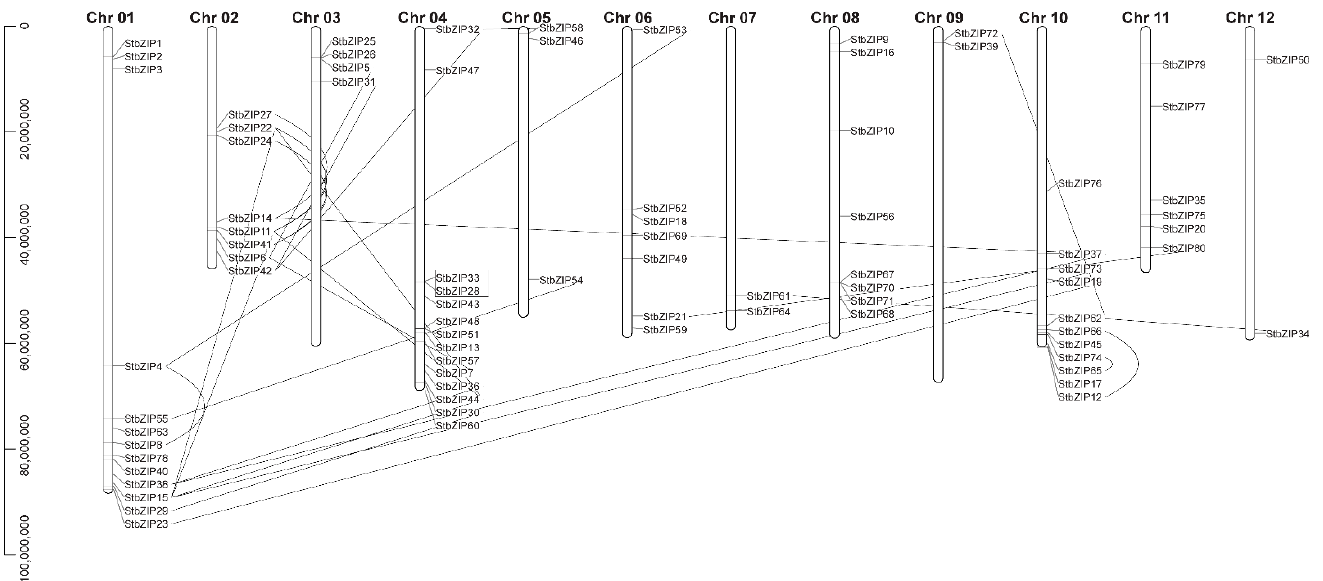
Figure 2. Distribution and segmental duplication of StbZIP gene family members in S. tuberosum chromosomes. The location of StbZIP genes on twelve chromosomes. The scale indicates the genome size of S. tuberosum (Mb). Bold lines connect paralogs, and segmental duplication was identified using MCScanX methods. The box identifies two genes representing a tandem duplication event.